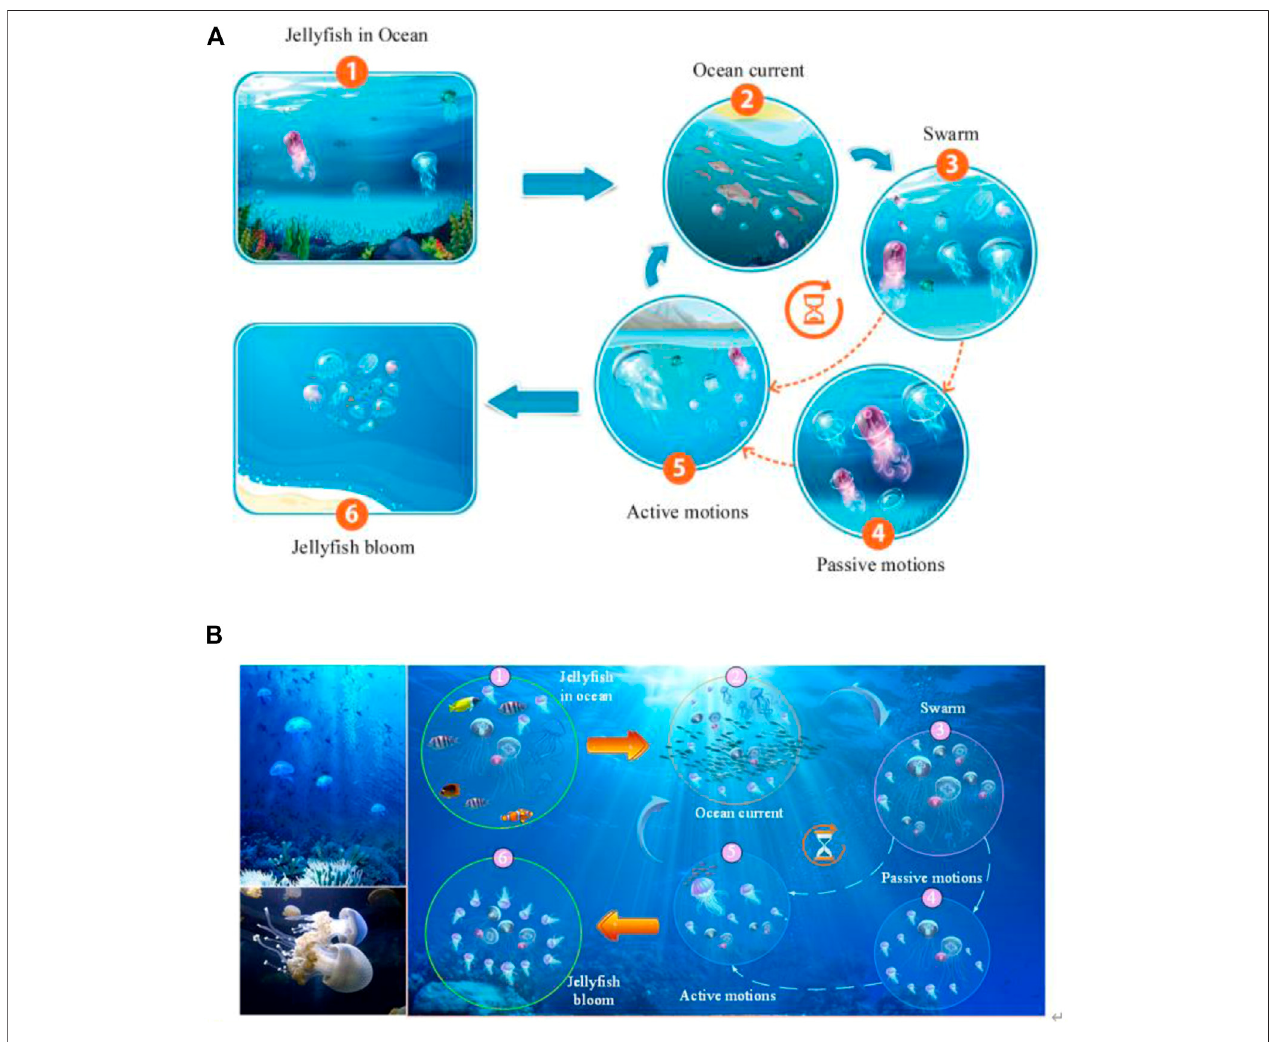
FIGURE 3 | Jelly fi sh ’ s behavior in the ocean. (A) the original fi gure source and (B) redecorated fi gure with citation.